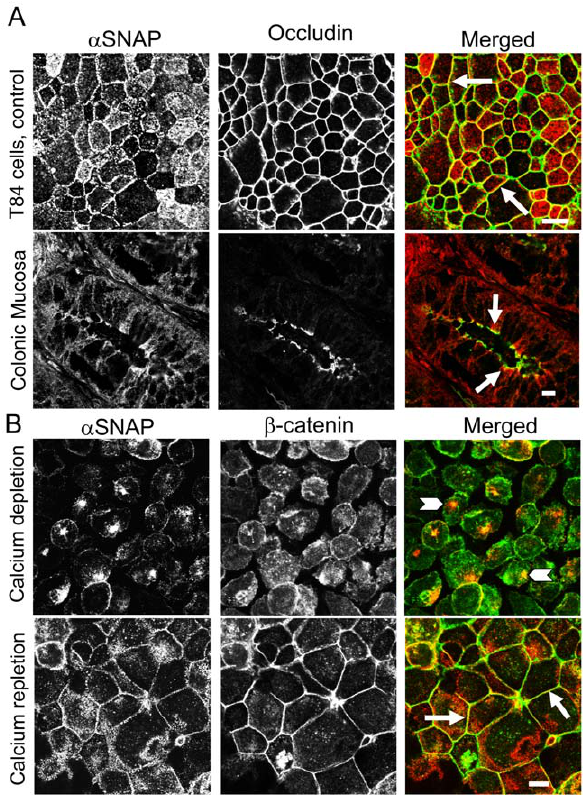
Figure 1. a SNAP is enriched at epithelial junctions invitro and invivo. ( A ) Dual immunofluorescence labeling and confocal microsco- py show colocalization (arrows) of a SNAP (red) and tight junction protein occludin (green) in confluent T84 cell monolayers and normal human colonic mucosa. ( B ) Immunofluorescence images show predominantly-perinuclear localization of a SNAP in calcium-depleted SK-CO15 cells (arrowheads) and its rapid translocation to newly-formed AJs in calcium-repleted cells (arrows). Scale bar, 10 m M.